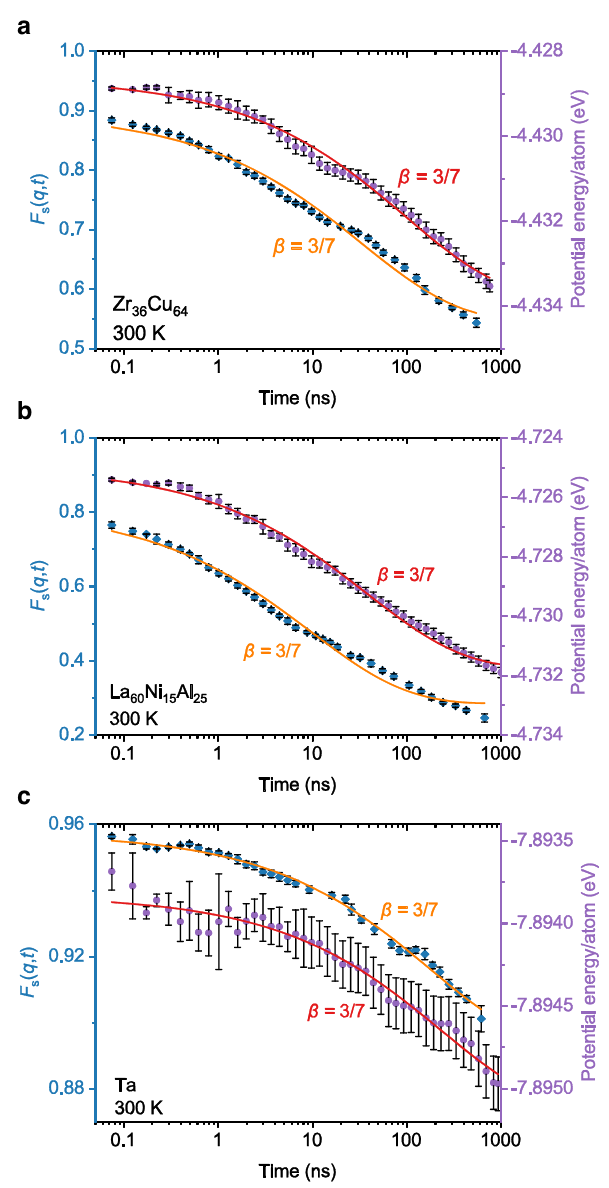
Fig.2|Roomtemperaturerelaxationdynamicsforvariousmetallicglasses.a-c Self-intermediate scattering function (diamonds) and potential energy (dots) evo- lutionsofZr 36 Cu 64 ( a ),La 60 Ni 15 Al 25 (b) ,andTa( c )inthevibration-acceleratedaging at 300K, together with fi ttings (solid lines) of KWW function with β =3 = 7. Fitting results indicate that aging dynamics in variousMGs at room temperature followsa universal stretched exponential decay with β =3 = 7. Error bars represent standard deviations.